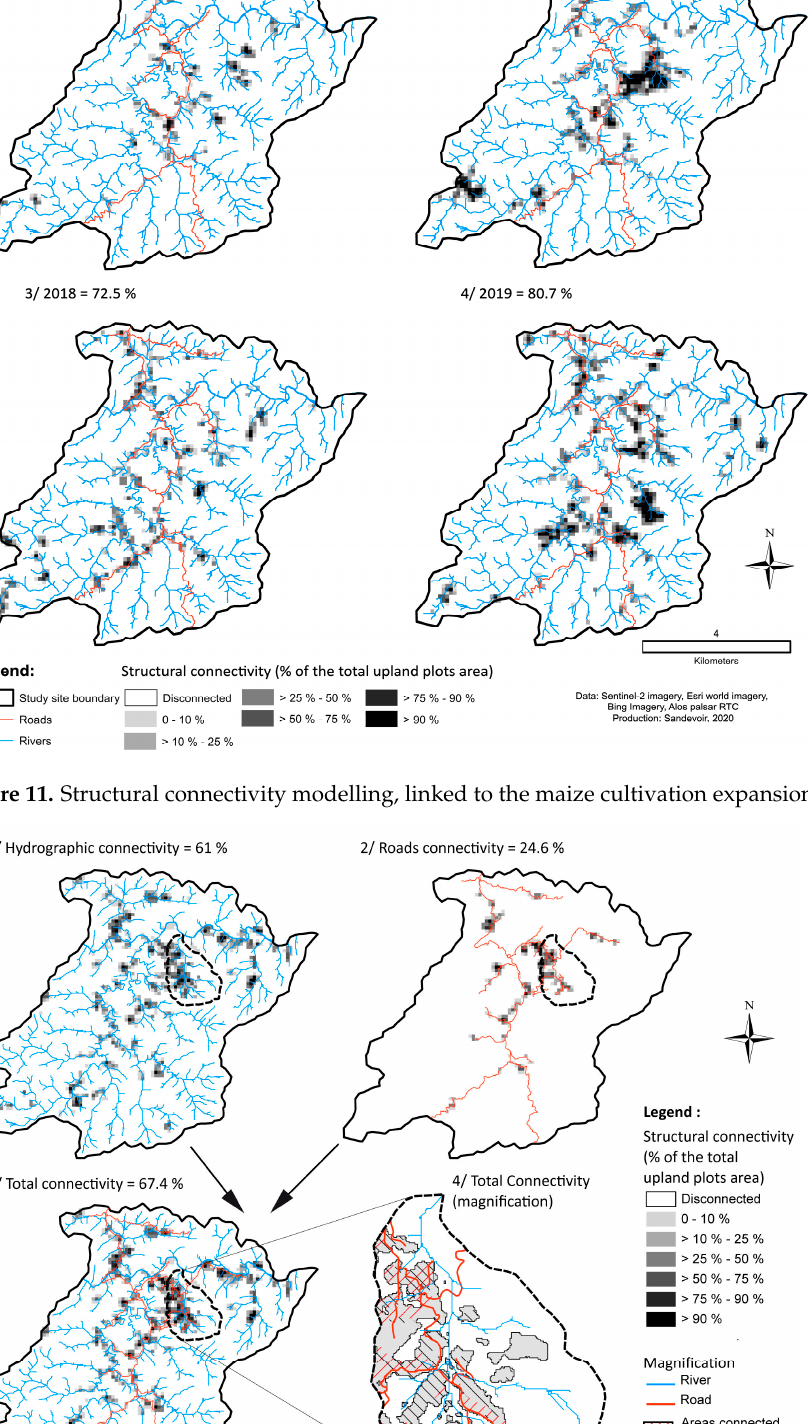
Figure 12. Hydrographic and road connectivity pa tt erns in 2020 linked to sugar cane development.